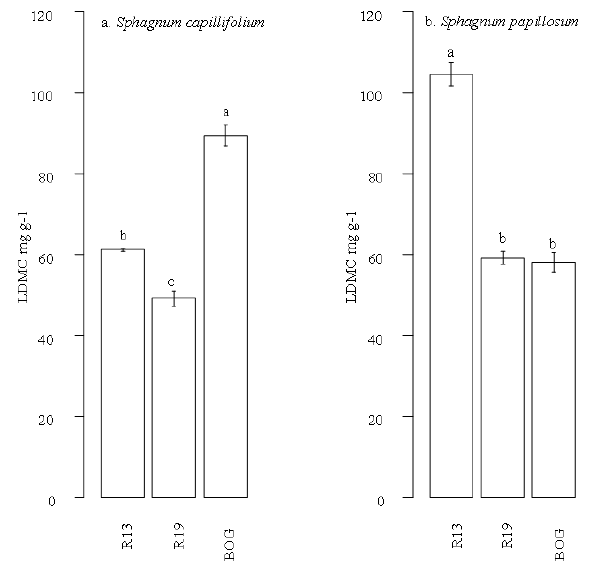
Figure 3. Mean and standard error (n = 5) values for destructive morphological traits measured for a) Sphagnum capillifolium and b) Sphagnum papillosum . LDMC = Leaf Dry Matter Content, BOG = open blanket bog control, R13 = forest-to- bog restoration site aged 13 years, R19 = forest-to- bog site aged 19 years. The letters above the bars indicate significant difference; i.e. for a given plant, where letters differ there was a significant effect of site (p <